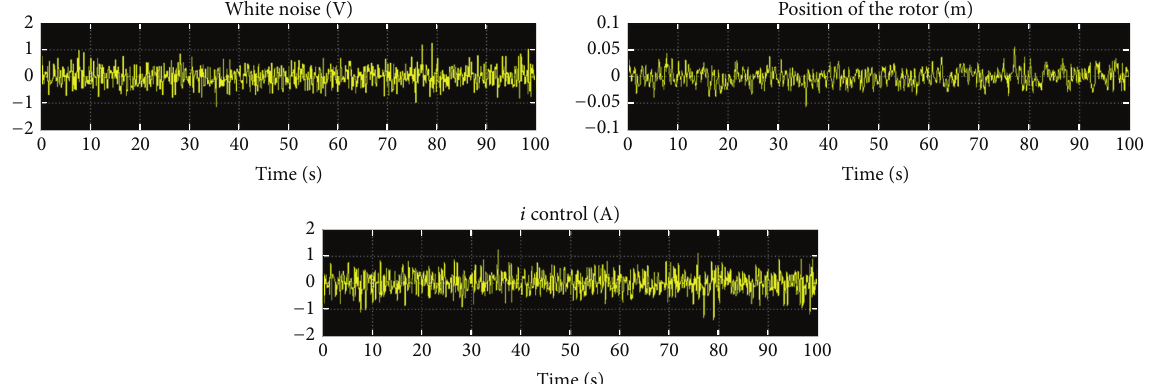
Figure 8: System response with PD controller with proportional gain of 12.2083 and gifferential gain of 1.9875 and white noise of 0.01 volts.